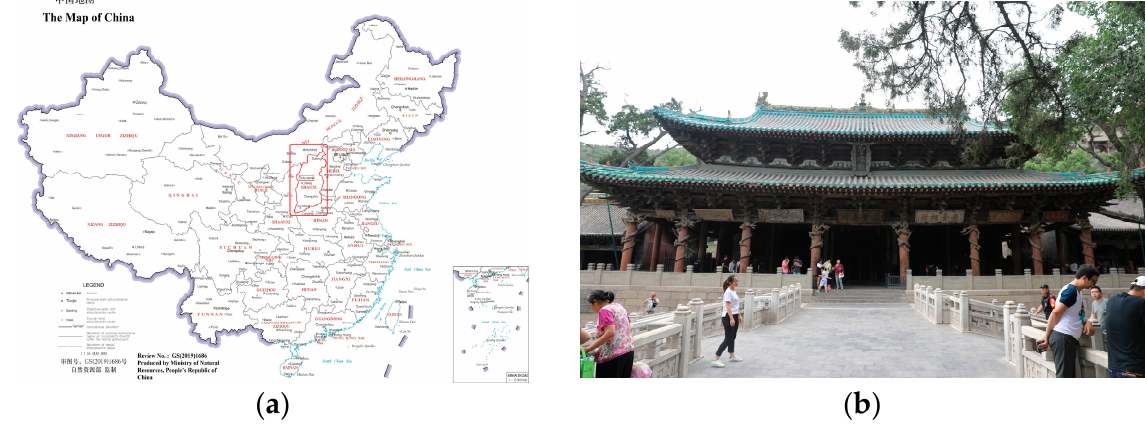
Figure 1. ( a ) Location of Shanxi province within China; ( b ) exterior view of the Sage Mother Hall.